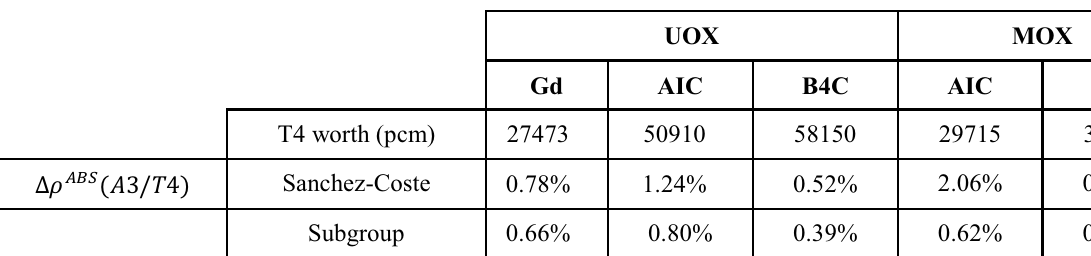
Table I. LWR-absorbers in UOX and MOX clusters: APOLLO3 ® /TRIPOLI-4 ® comparisons on reactivity